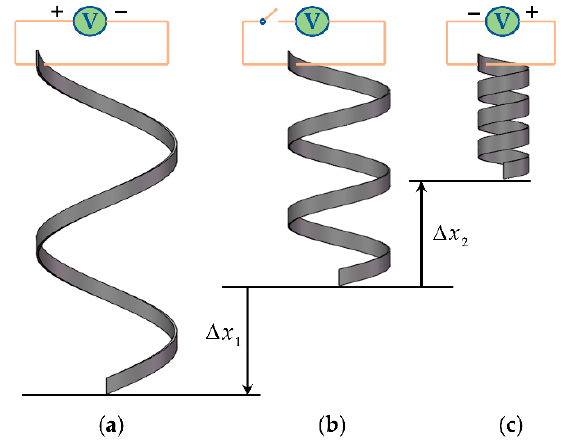
Figure 5. Schematic diagram of the helical IPMC actuator: ( a ) elongated state; ( b ) natural state; ( c ) shortened state.